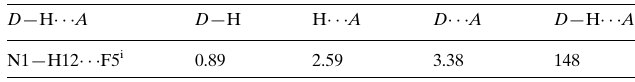
Hydrogen-bond geometry (A˚ , (cid:4)